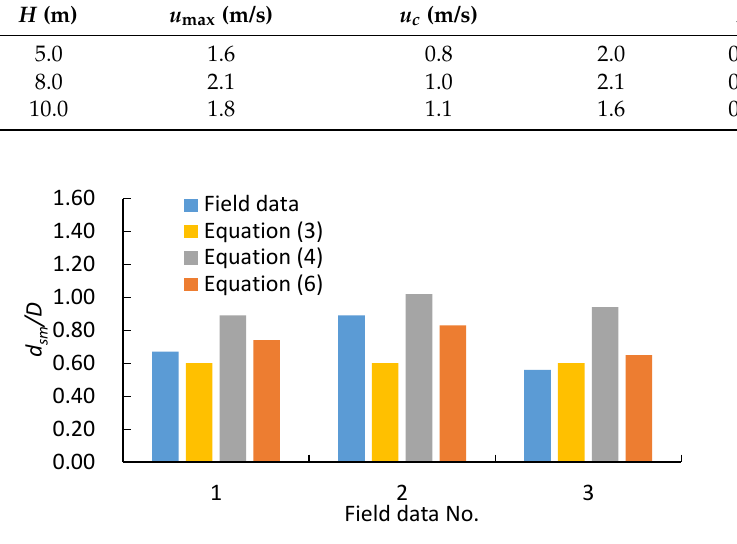
Figure 15. Comparisons of field data and predicted scour depths using different equations. Table 3. Statistics of predicted error using different equations.